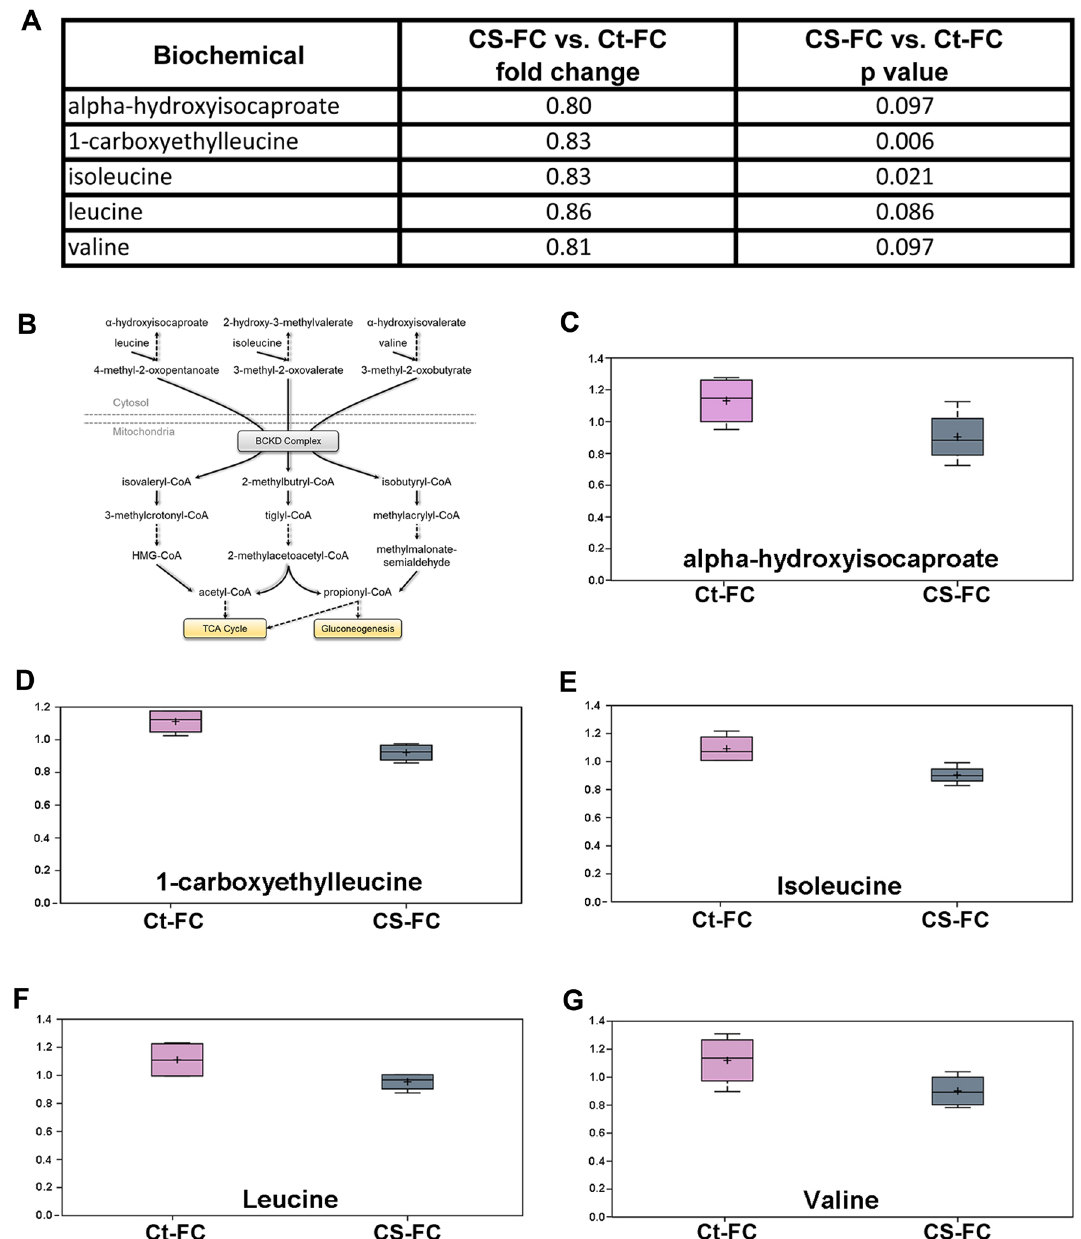
acid dehydrogenase (BCKD), a multi-enzyme complex, which catalyzes BCAAs to the corresponding acyl- CoA derivatives. ( C–G) Box plots depicting relative levels of BCAAs metabolites in lens FC of CS-exposed and untreated Ct mice. Diminished levels of (C) alpha-hydroxyisocaproate, (D) 1-carboxyethylleucine, (E) Isoleucine, (F) Leucine, and (G) Valine were identified in lens FC of mice exposed to